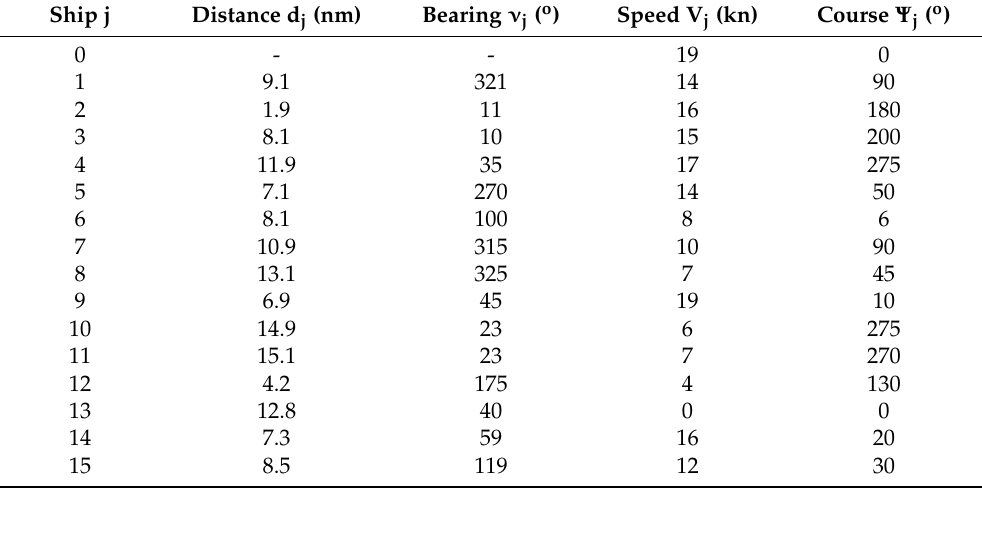
Table 1. Motion variables of the considered ship and 15 encountered ships.